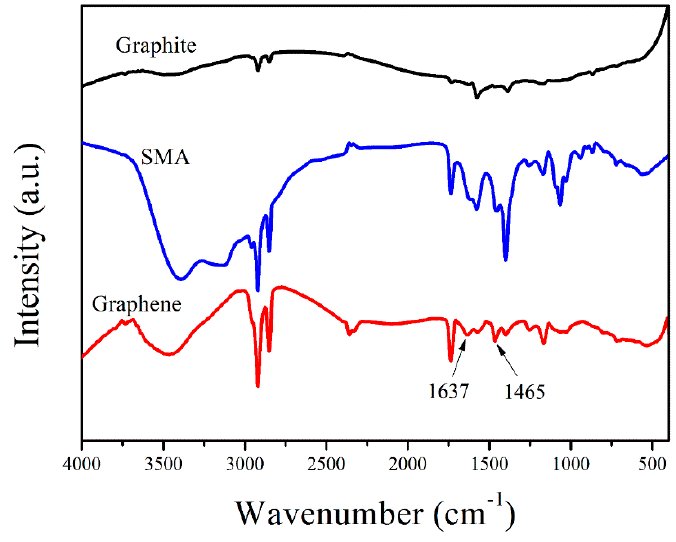
Figure 9. Fourier-transform infrared (FTIR) spectra of graphite, SMA, and EG.